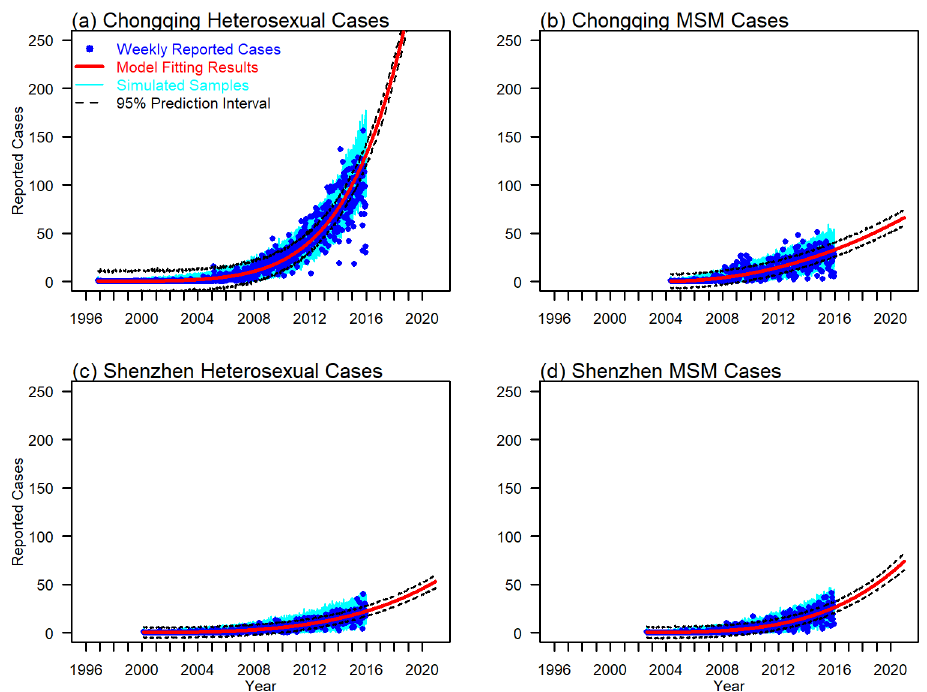
Fig 2. We fit the sub-exponential models to weekly reported cases of Chongqing and Shenzhen, and predict their trends from 2016 to 2020. Panel (a) and (b) present fitting results for heterosexuals and MSM populations in Chongqing, (c) and (d) present those of Shenzhen. Red solid lines show the simulation results. Blue solid dots show the weekly reported cases. Cyan lines indicate the results of 1,000 Poisson simulations. Black dashed lines represent the 95% prediction